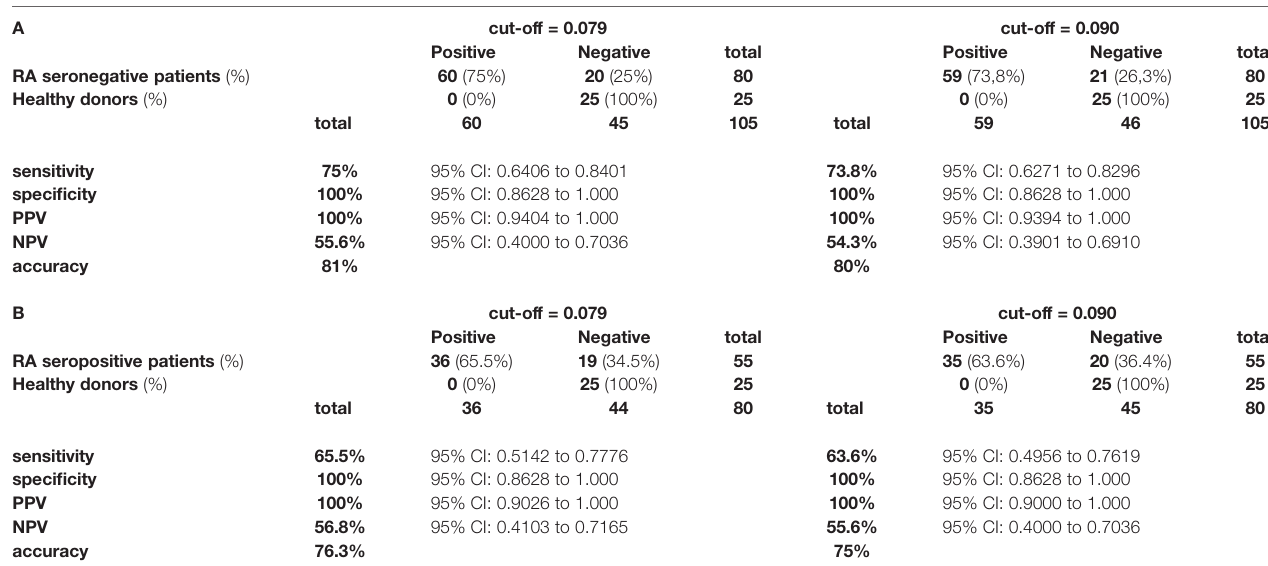
(A) RAseronegativepatients andhealthydonors; (B) RAseropositive patientsandhealthydonors;diagnosticpowersoftheElisatest.Highlevelsarede fi nedas abovethethresholdvalue of mean +/- 3 S.D. of healthy donors (HD), cut-off = 0.079; or above a hypothetical cutoff value with a more stringent threshold, cut-off = 0.090. Data are analyzed as categorical variable with GraphPad Prism 5. Fisher ’ s exact test, two-sided; p value ˂ 0.0001. Abs, antibodies; PPV, positive predictive value; NPV, negative predictive